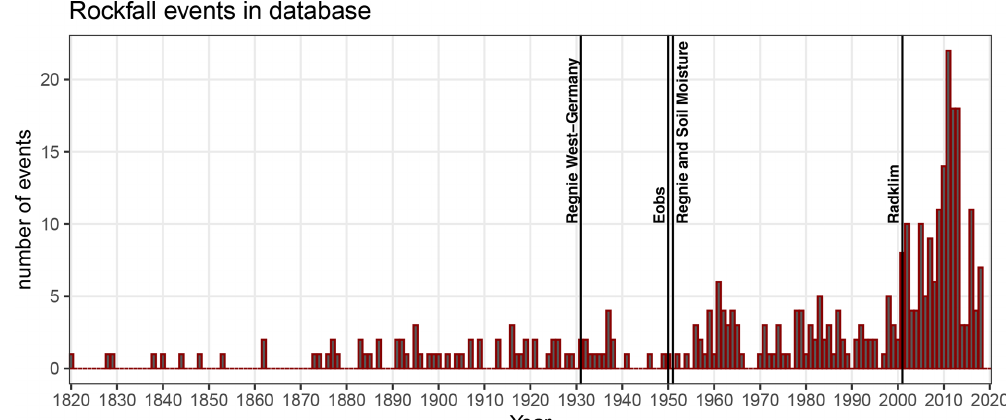
Figure 2. Time series of the number of rockfall events per year included in the database. The years at which the meteorological and hydro- logical observations start are